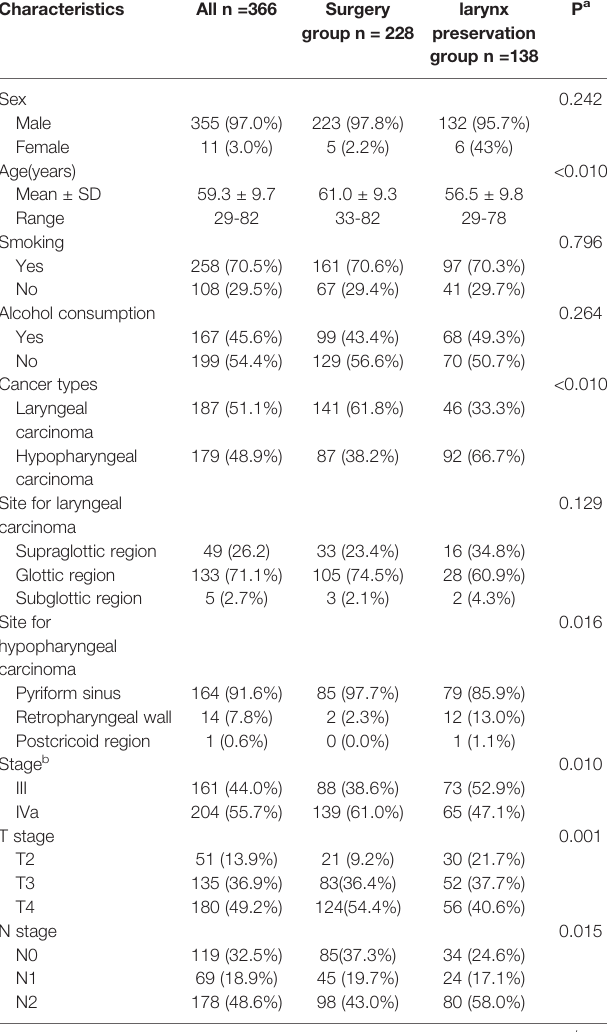
TABLE 1 | Demographic and clinical characteristics of the patients with laryngeal and hypopharyngeal carcinoma. Characteristics